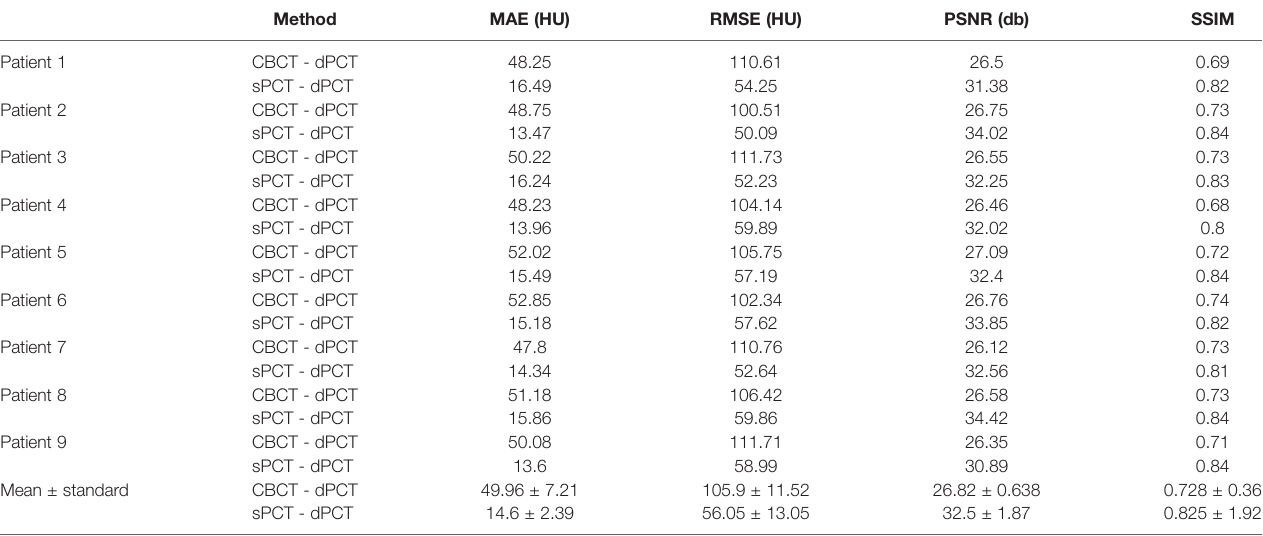
TABLE 1 | Mean and standard deviation of CBCT - dPCT and sPCT - dPCT in all 9 test patients.